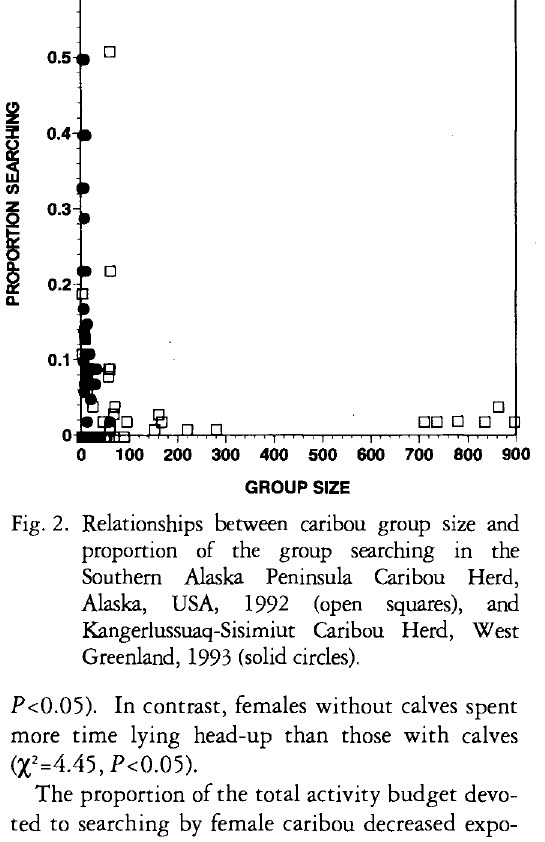
Fig. 2. Relationships between caribou group size and proportion of the group searching in the Southern Alaska Peninsula Caribou Herd, Alaska, USA, 1992 (open squares), and Kangerlussuaq-Sisimiut Caribou Herd, West Greenland, 1993 (solid circles). P<0.05). In contrast, females without calves spent more time lying head-up than those with calves (X 2